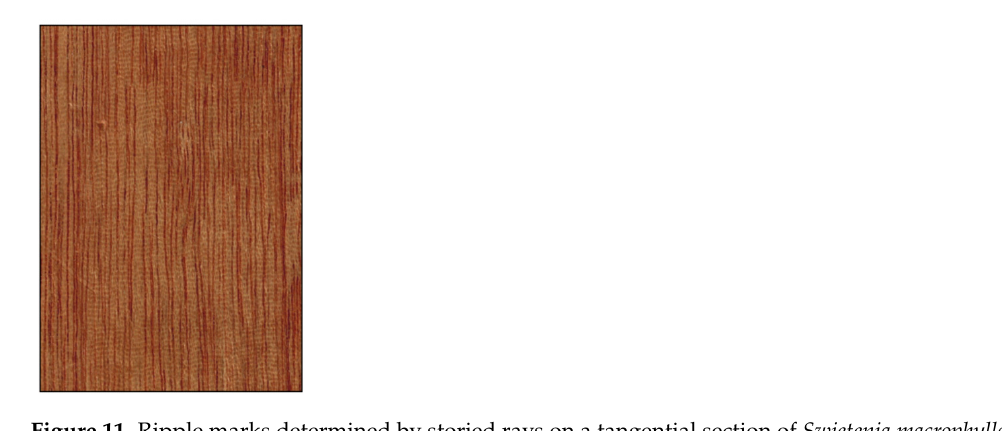
Figure 11. Ripple marks determined by storied rays on a tangential section of Swietenia macrophylla . Table 11. Examples of species for different ray features in